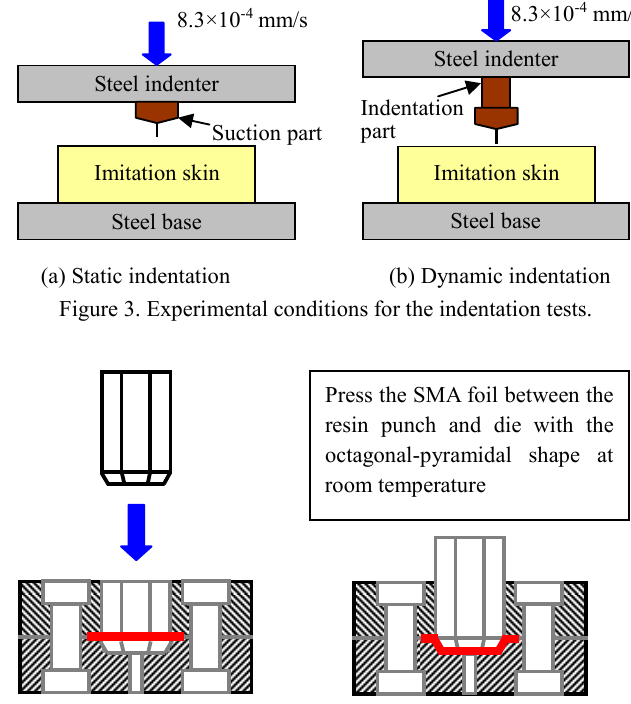
Figure 4. Forming process of SMA octagonal-pyramidal foil at room temperature for either blood suction or drug